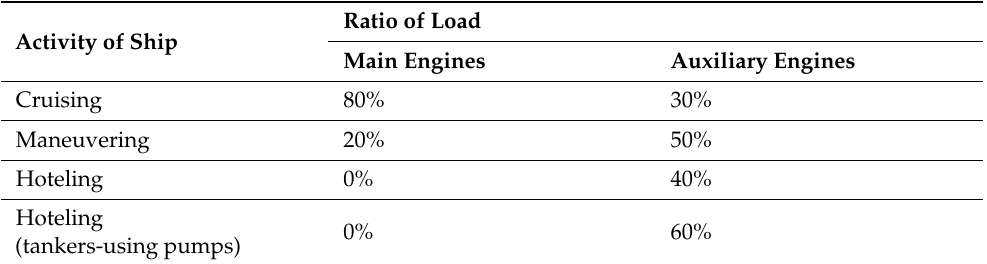
Table 3. Ratio of load factor for main engine and aux engine of ships [25].